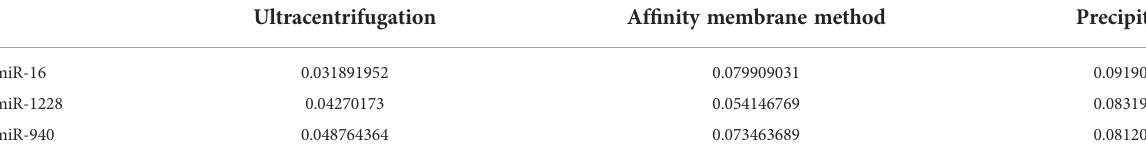
TABLE 3 Coef fi cient of variation (CoV) of miRNA expression in exosomes extracted using different